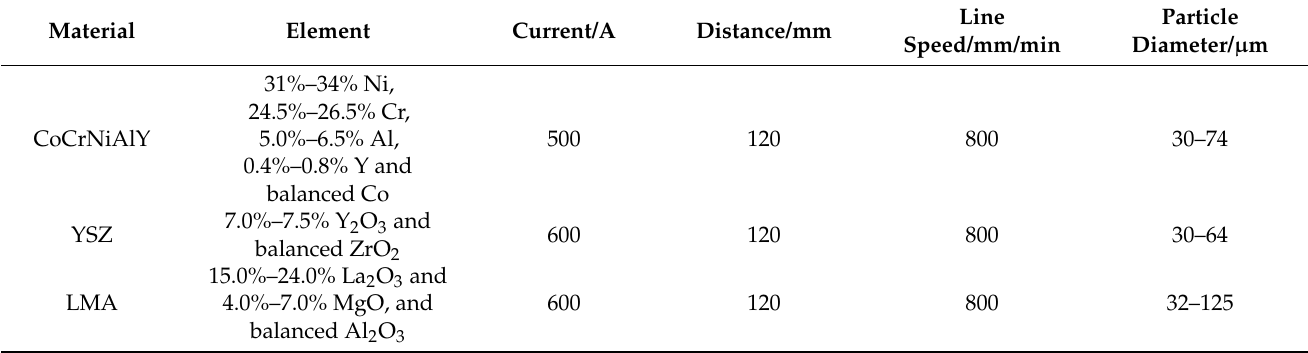
Table 1. Spraying powder composition and spraying parameters of each